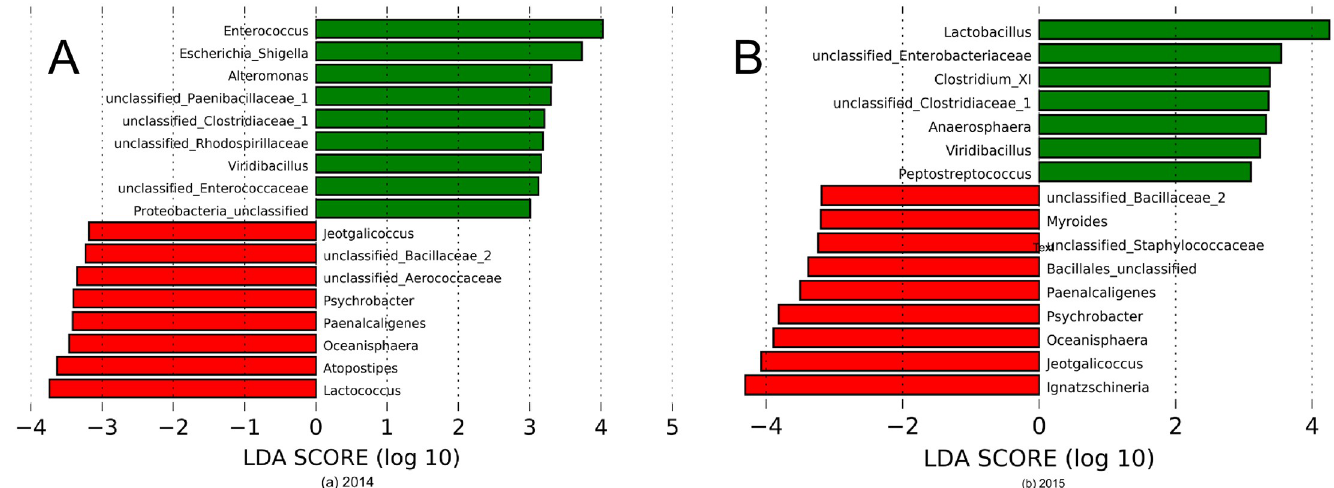
Fig 3. Linear discriminant analysis effect size (LEfSe) indicating differentially enriched fecal bacterial communities (with LDA score > 3) at the genus level between adult females (red, n = 164) and weaned kits (green, n = 168) in summer 2014 (a) and summer 2015 (b) (n = 332). Samples were obtained from 43 and 46 farms in 2014 and 2015, respectively.